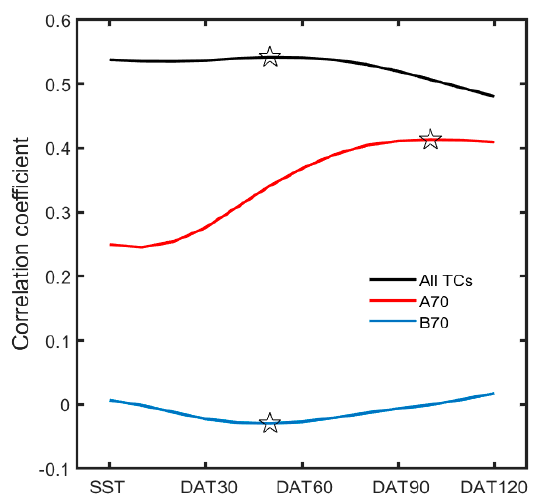
Figure 5. Comparison of correlation coefficients between various DATs and LMI for A70, B70, and all TCs. Black, red, and blue lines indicate unclassified TWNP TCs (i.e., all TCs), A70, and B70, respectively. Open stars represent the locations with the maximum values for each group.